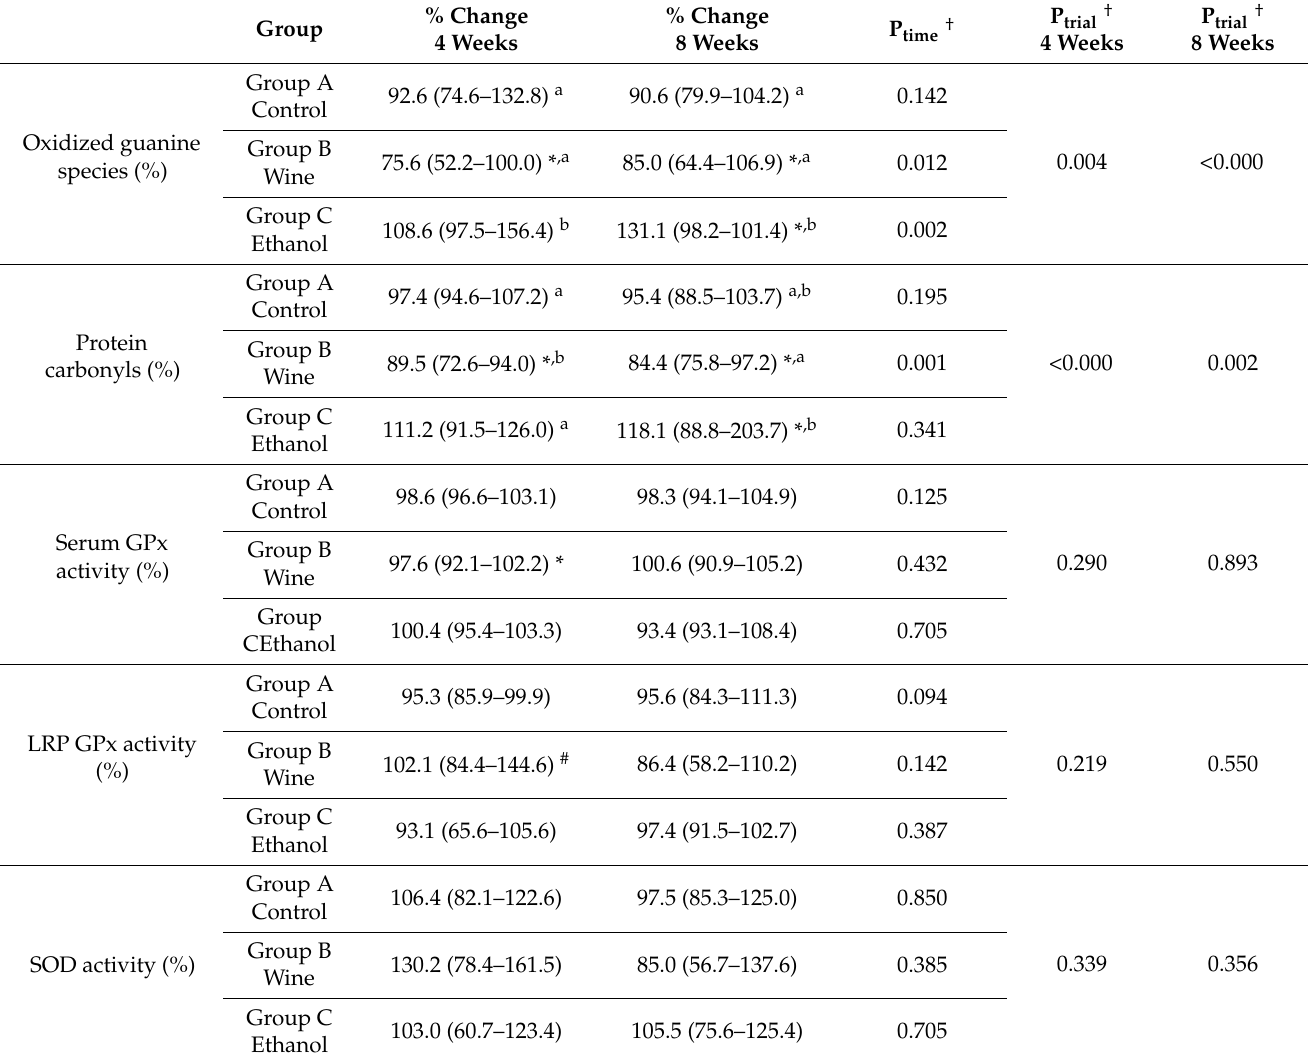
Table 4. % Change of baseline values in oxidative stress